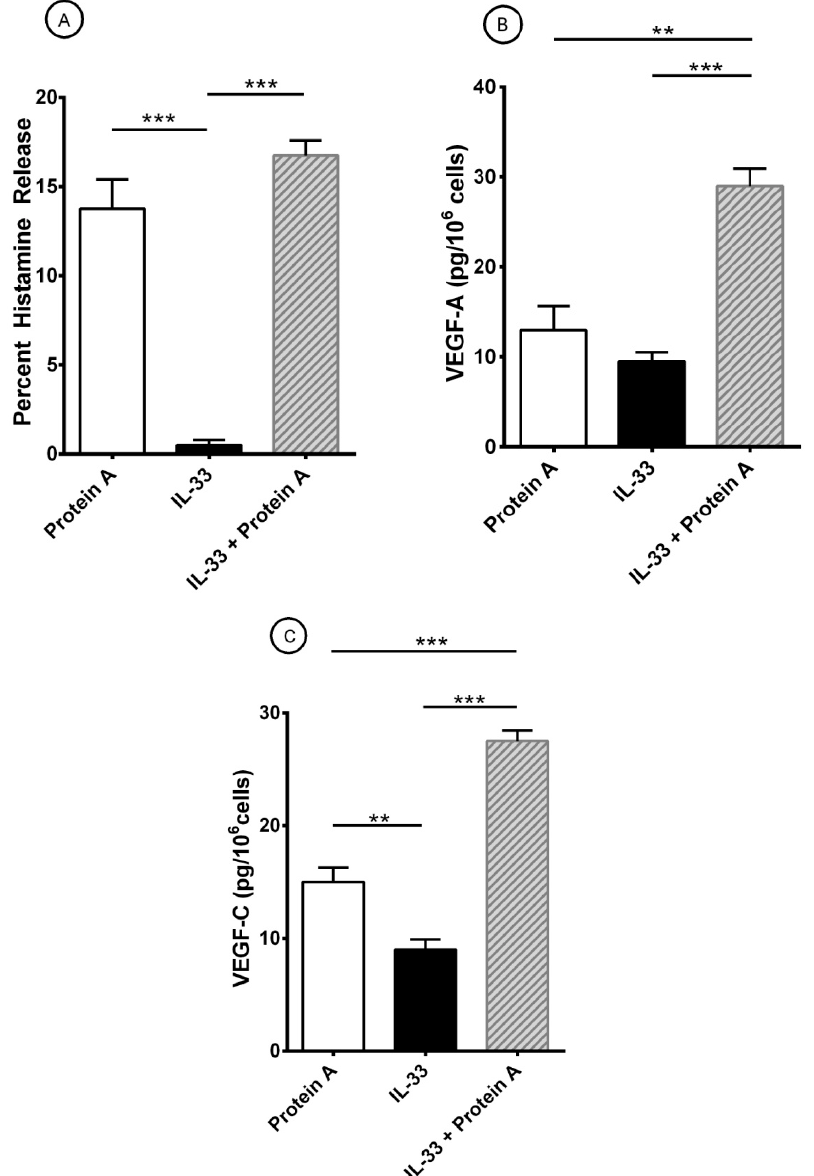
Figure 4. Effects of short-term priming by IL-33 an protein A-induced release of histamine ( A ), VEGF-A ( B ), and VEGF-C ( C ) from HLMCs. Mast cells were preincubated (30 min at 37 ◦ C) with IL-33 (30 ng/mL) before exposure to protein A (100 nM). After 45 min incubation at 37 ◦ C, HLMCs were harvested, centrifuged, and histamine release measured in the supernatants. For the evaluation of VEGFs, HLMCs were incubated for 12 h at 37 ◦ C. At the end of incubation, cells were harvested, centrifuged and VEGF-A and VEGF-C measured in the supernatants. Results show the mean ± SEM obtained in three experiments. ** p < 0.01; *** p < 0.001.